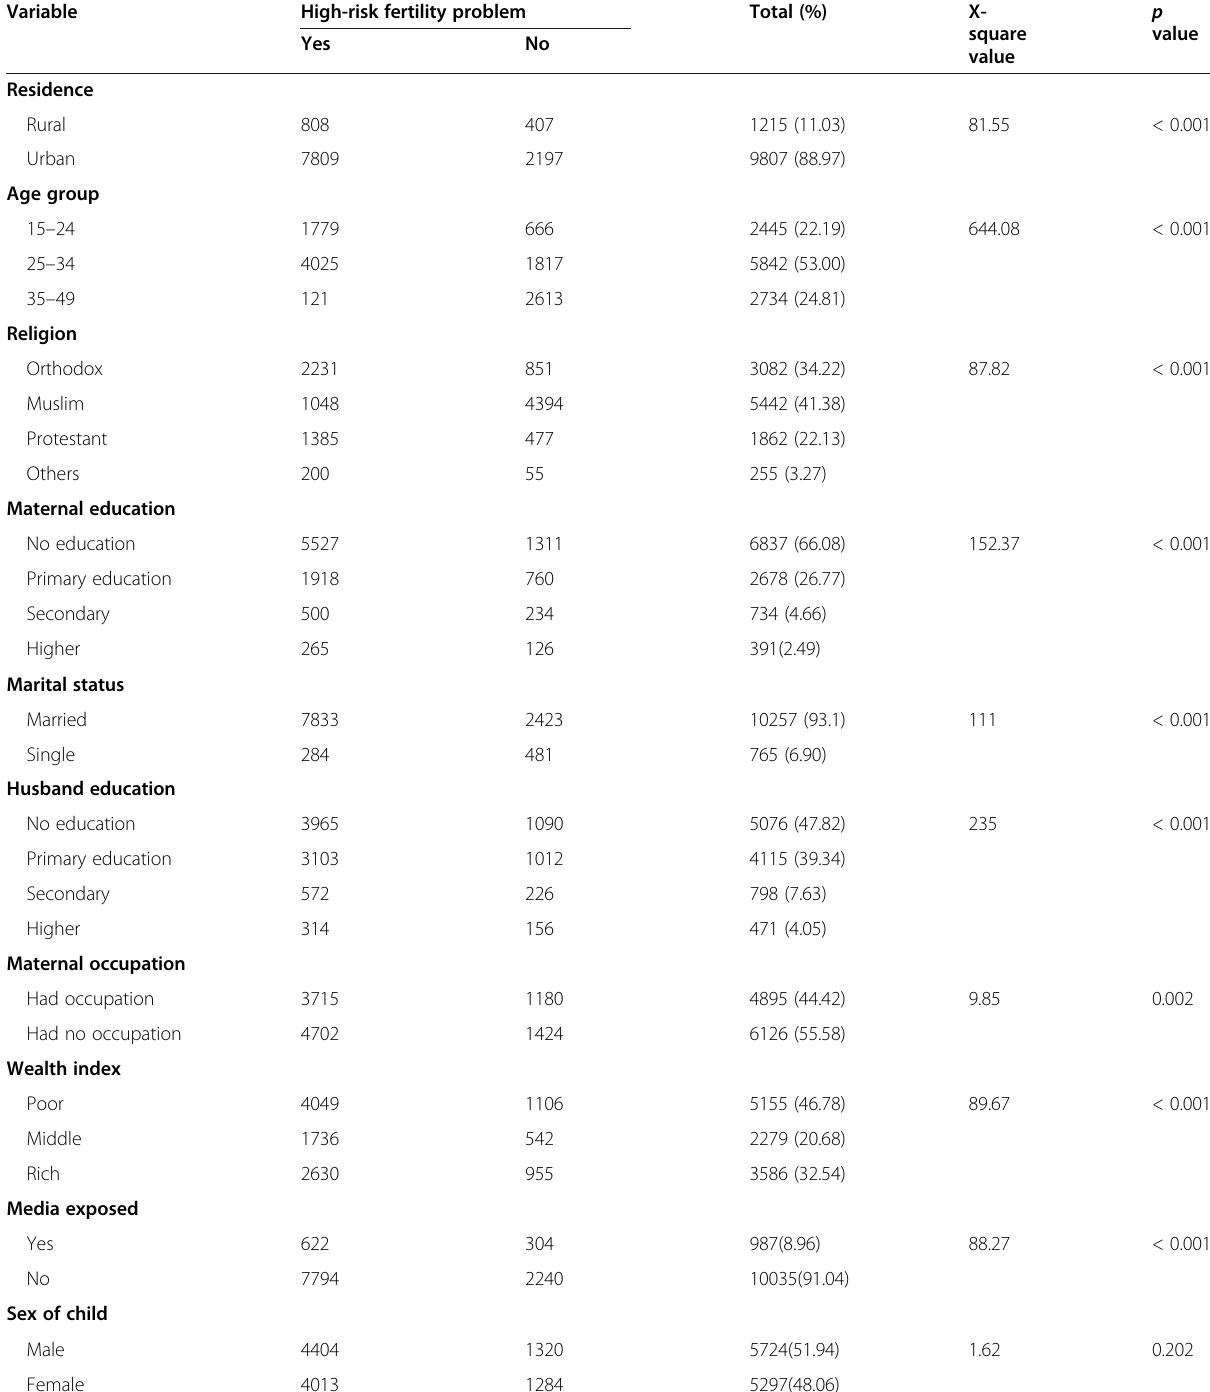
Table 1 Sociodemographic characteristics of women who gave birth in the preceding 5 years before the survey in Ethiopia, 2016 ( n =